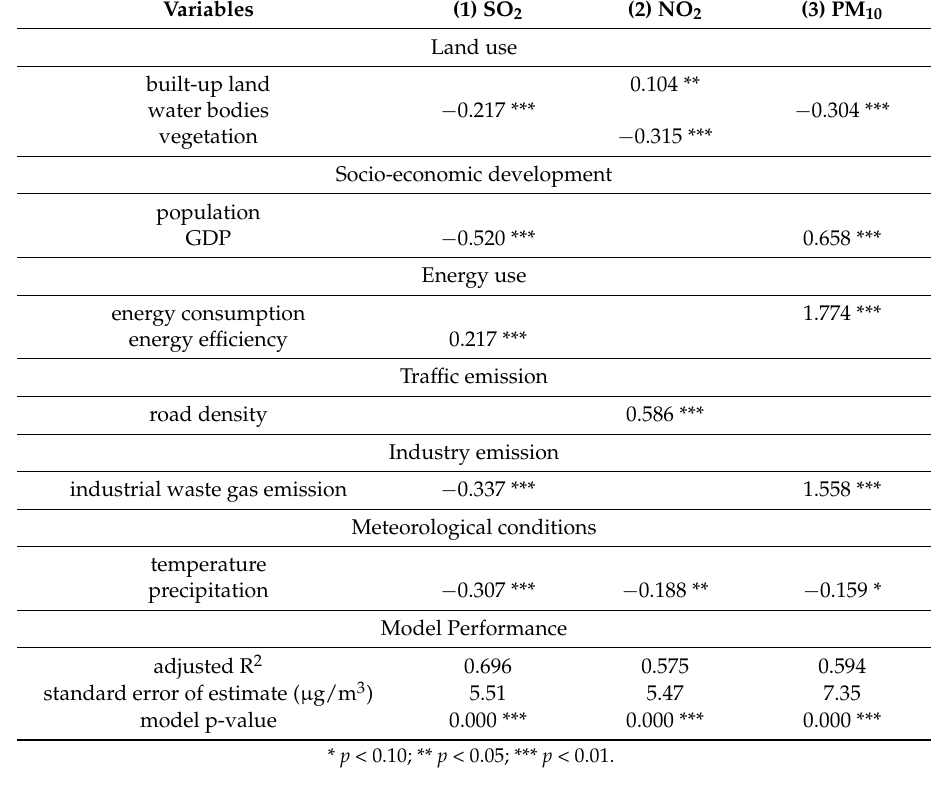
Table 4. Standardized coefficients for stepwise linear regression models.